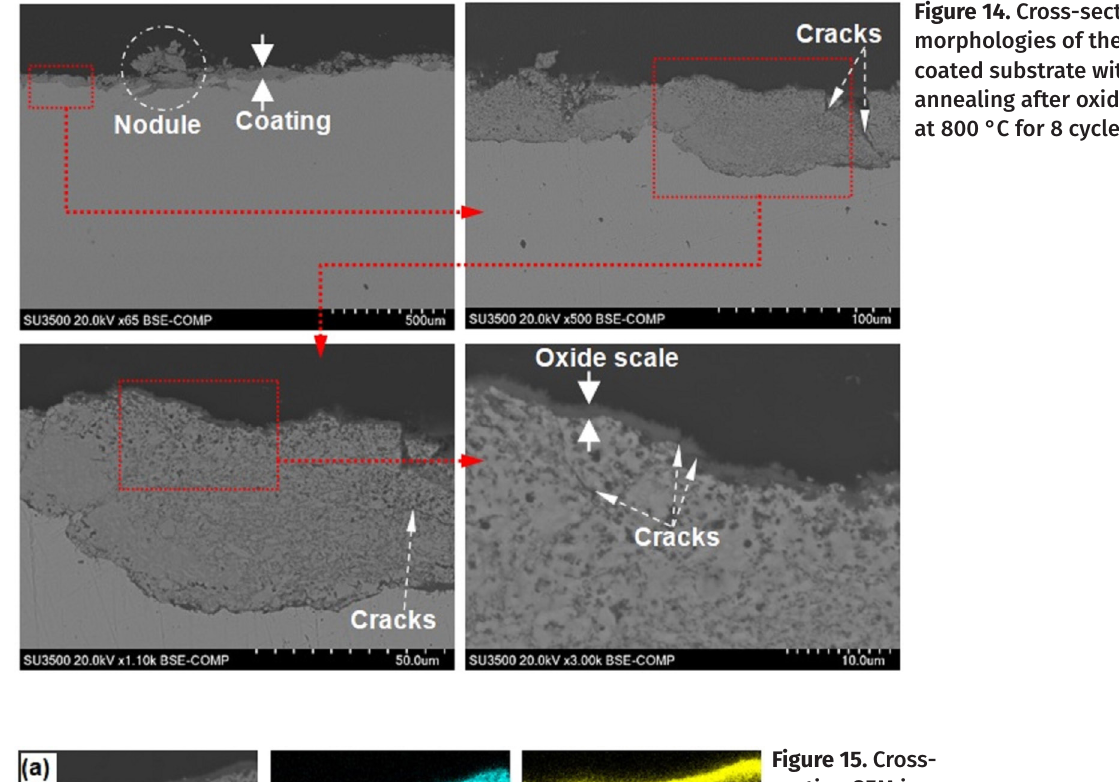
Figure 15. Cross- section SEM images and element mapping of coated substrate after oxidation for the coated substrate (a) before and (b) after